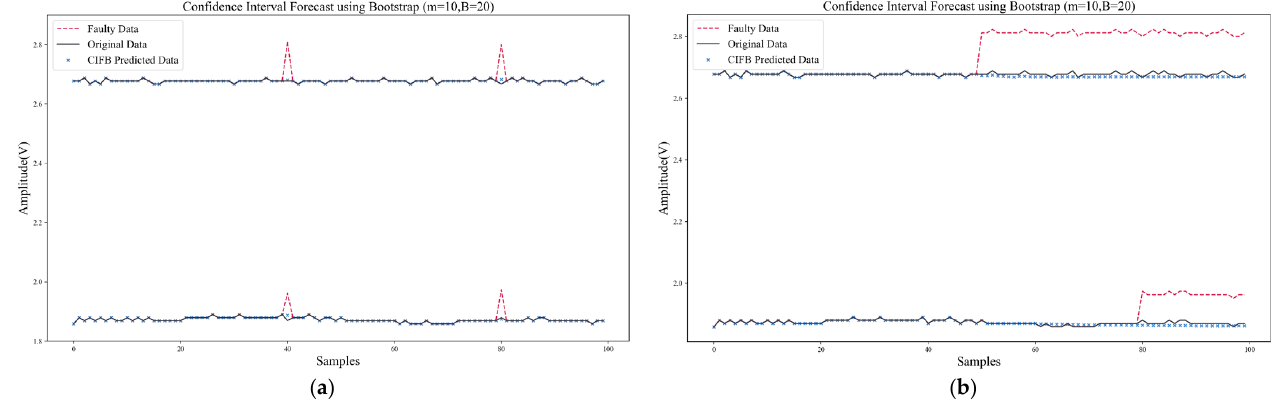
Figure 15. Multi-faults isolation and recovery of CIFB: ( a ) Multiple transient faults; ( b ) Multiple persistent faults.